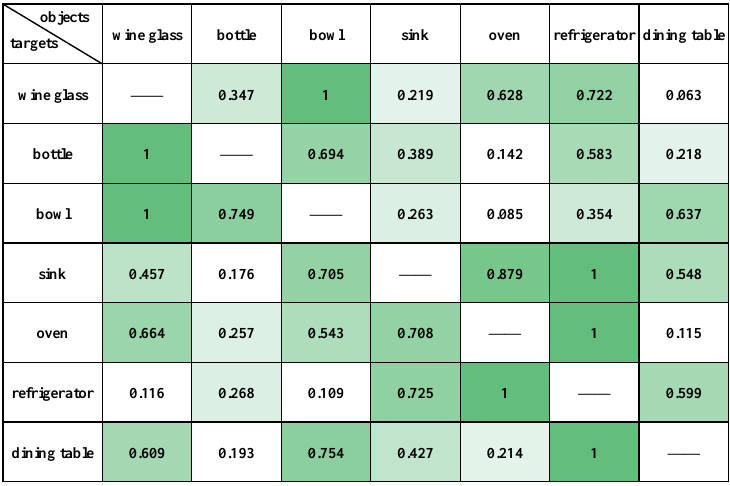
10 of 17 Figure 7. Reliability test results of the semantic association model for the office places. 4.1.2. Kitchen Places A total of 500 pictures consisting of several typical objects in kitchen places are also